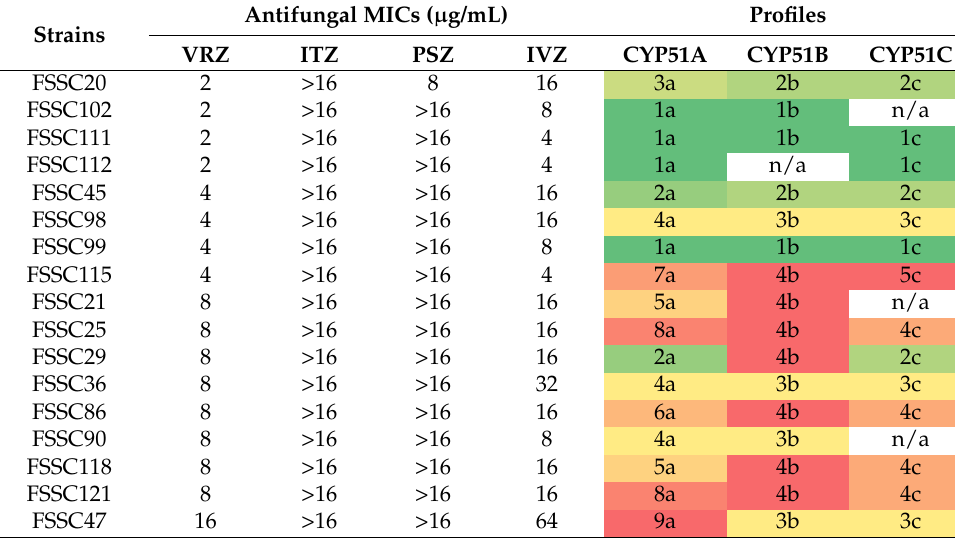
Table 5. Minimum inhibitory concentrations (MICs) of the FSSC strains for azole antifungals (voriconazole (VRZ), itraconazole (ITZ), posaconazole (PSZ), isavuconazole (IVZ)) and corresponding homology profiles of CYP51A, B, and C for each FSSC strain (n/a: data unavailable). Studied strains are classified in ascending order of voriconazole MICs. MICs for other tested azoles are also shown. Each protein sequence of CYP51A, B, and C was compared between the different FSSC strains and observed homologies were used to define profiles. Two strains share the same profile when their protein sequences present more than 99% of similarity. Profiles are noted with a number and a letter corresponding to the isoform. Numbers were chosen arbitrarily based on the order of strains with respect to voriconazole MIC. For each CYP51 isoform, the color gradient corresponds to the proximity of the protein profiles to each other (from green to